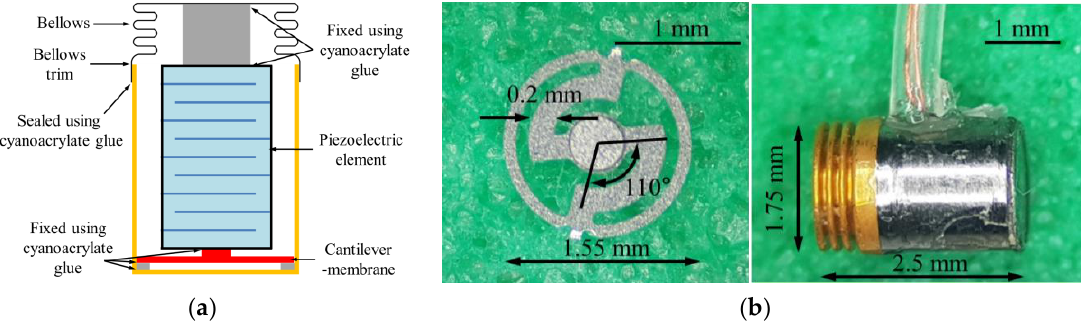
Figure 6. ( a ) Cross section of the piezoelectric actuator; ( b ) cantilever membrane (left) fabricated through etching, and assembled piezoelectric actuator (right).